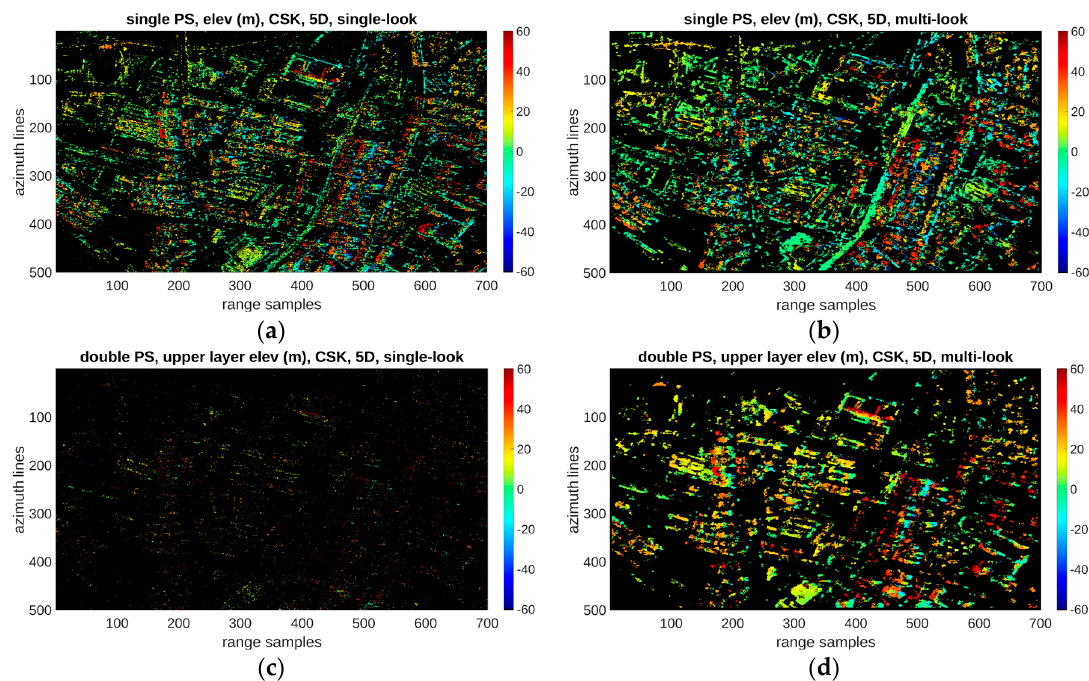
Figure 7. Distribution of the detected single scatterers ( a , b ) and higher double ( c , d ) scatterers, for single-look ( a , c ) and multi-look ( b , d ) analysis Colormap is in meters and set according to the estimated elevation.